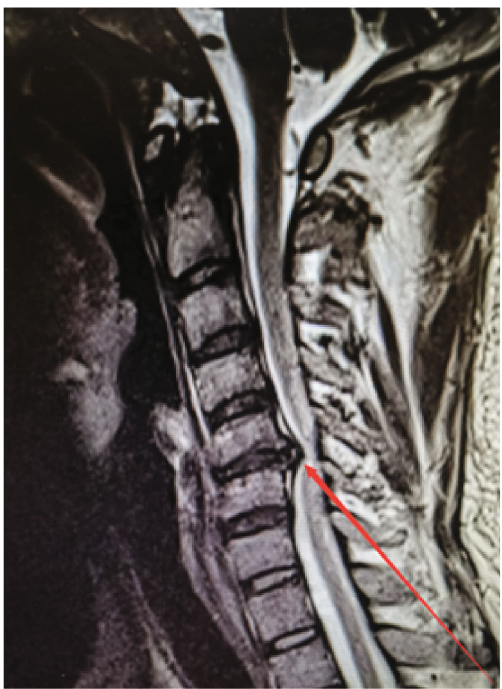
Figure 1: MRI shows obvious spinal stenosis caused by bony narrow or backward protrusion or prolapse of intervertebral